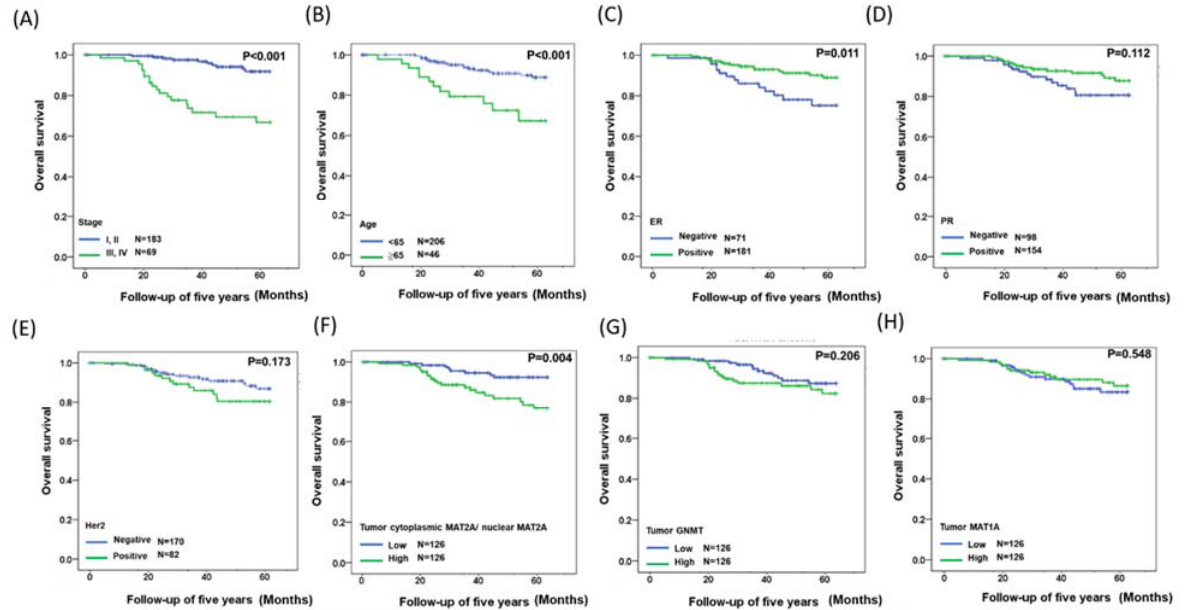
Figure 3. Kaplan–Meier analysis of clinical data, GNMT, MAT1A, and C/N ratio of MAT2A protein expressions in breast cancer patients. ( A ) Overall survival estimates for stage. ( B ) Overall survival estimates for age. ( C ) Overall survival estimates for ER expression. ( D ) Overall survival estimates for PR expression. ( E ) Overall survival estimates for HER2 expression. ( F ) Overall survival estimates for C/N ratio of MAT2A expression. ( G ) Overall survival estimates for GNMT expression. ( H ) Overall survival estimates for of MAT1A expression.